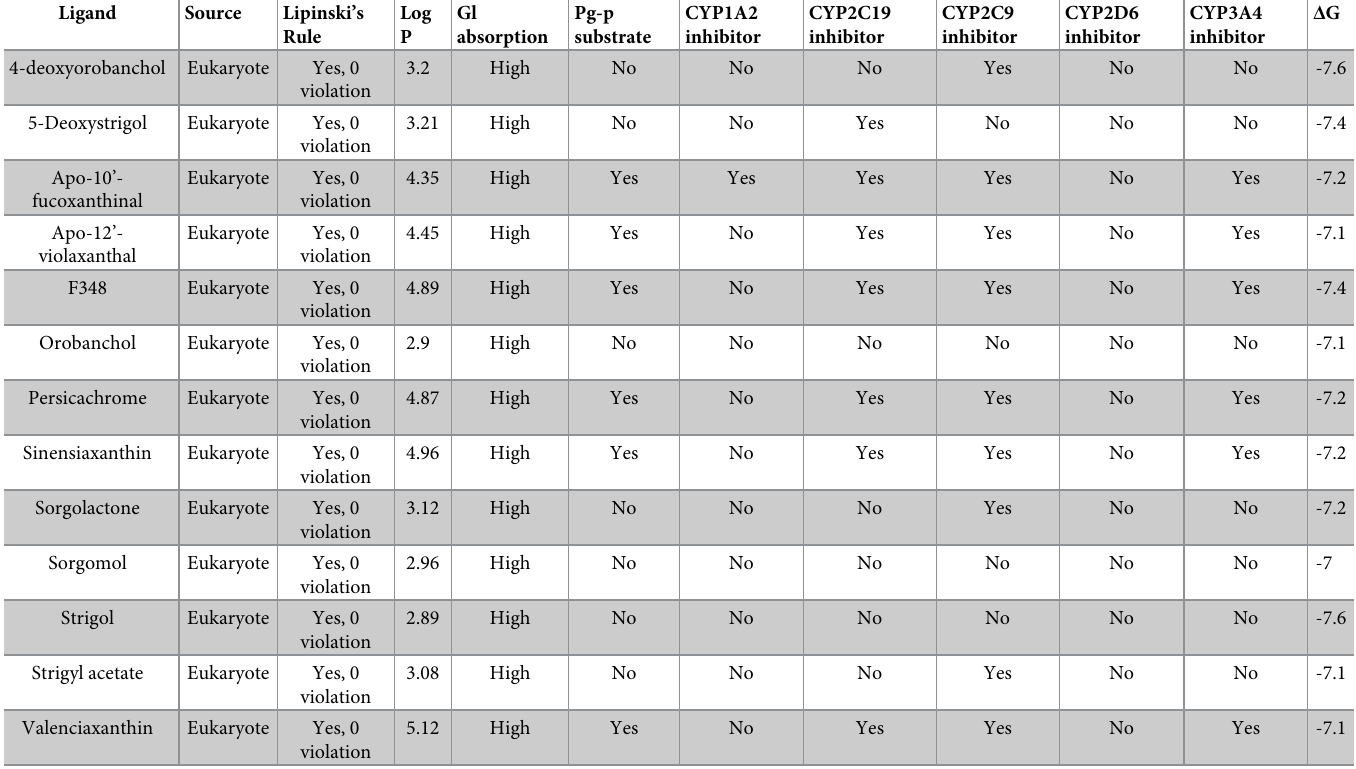
Table 2. Carotenoids with the most favorable Δ G value.